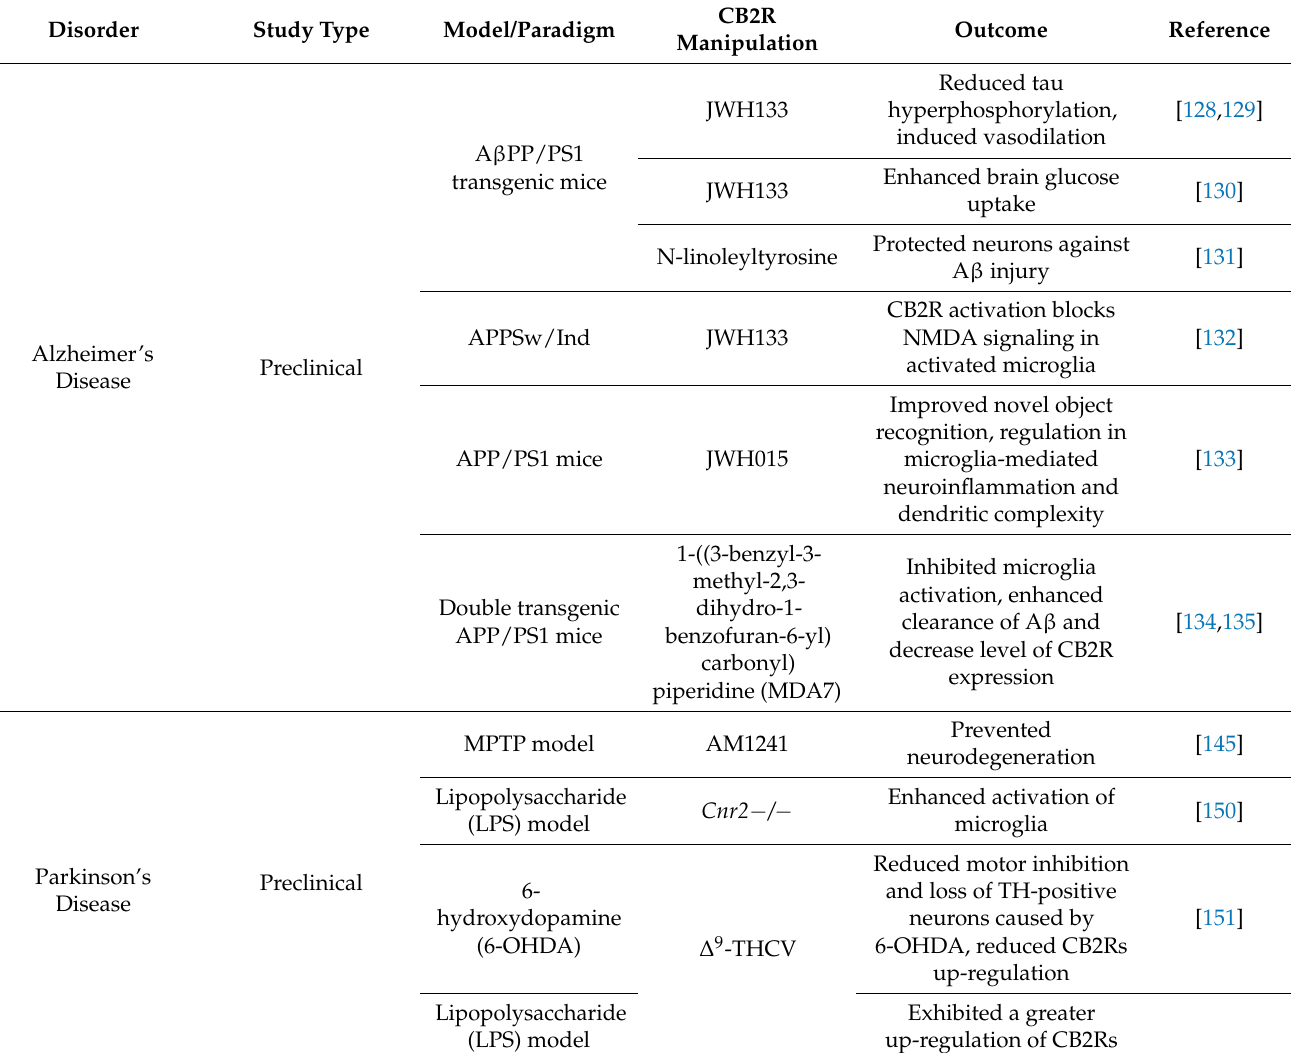
Table 2. CB2 cannabinoid receptors in neurological and neurodegenerative